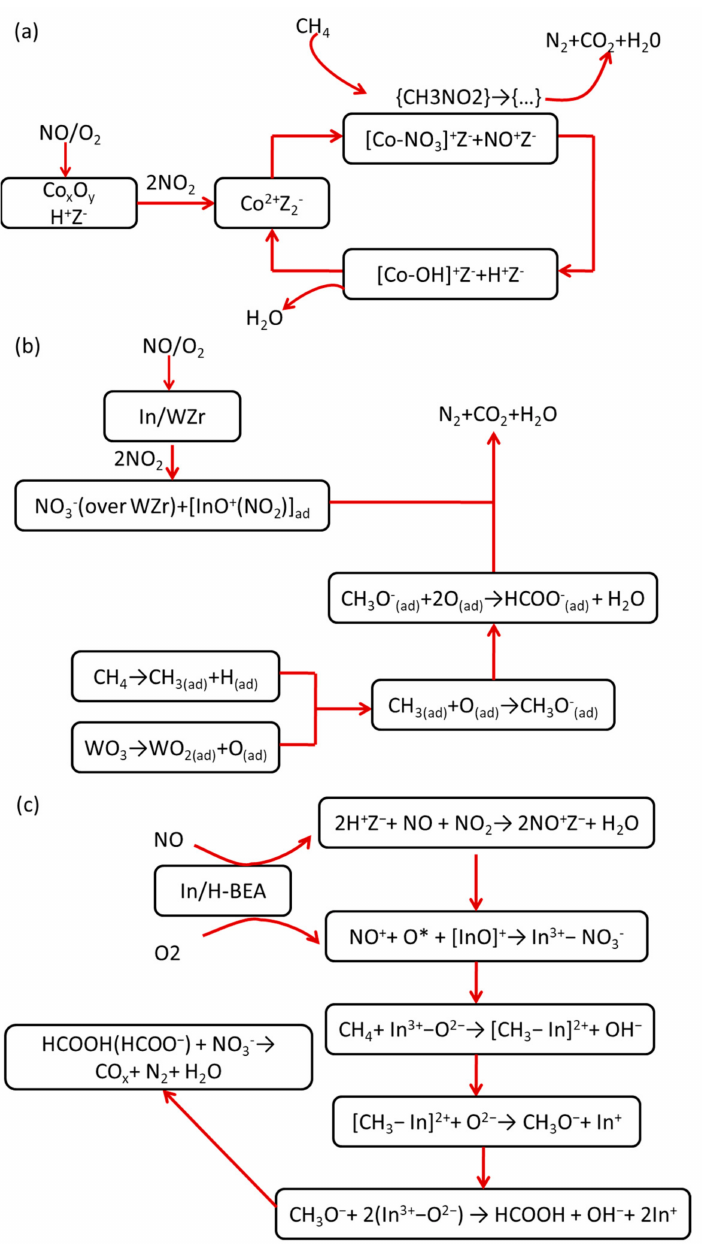
Figure 5. Schematic illustration of possible NO+CH 4 reaction mechanism over ( a ) Co/H-ZSM, ( b ) In/WO 3 /ZrO 2 , and ( c ) In/H-BEA catalysts. Figure 5c indicates the process of NO removal by CH 4 over In/H-BEA